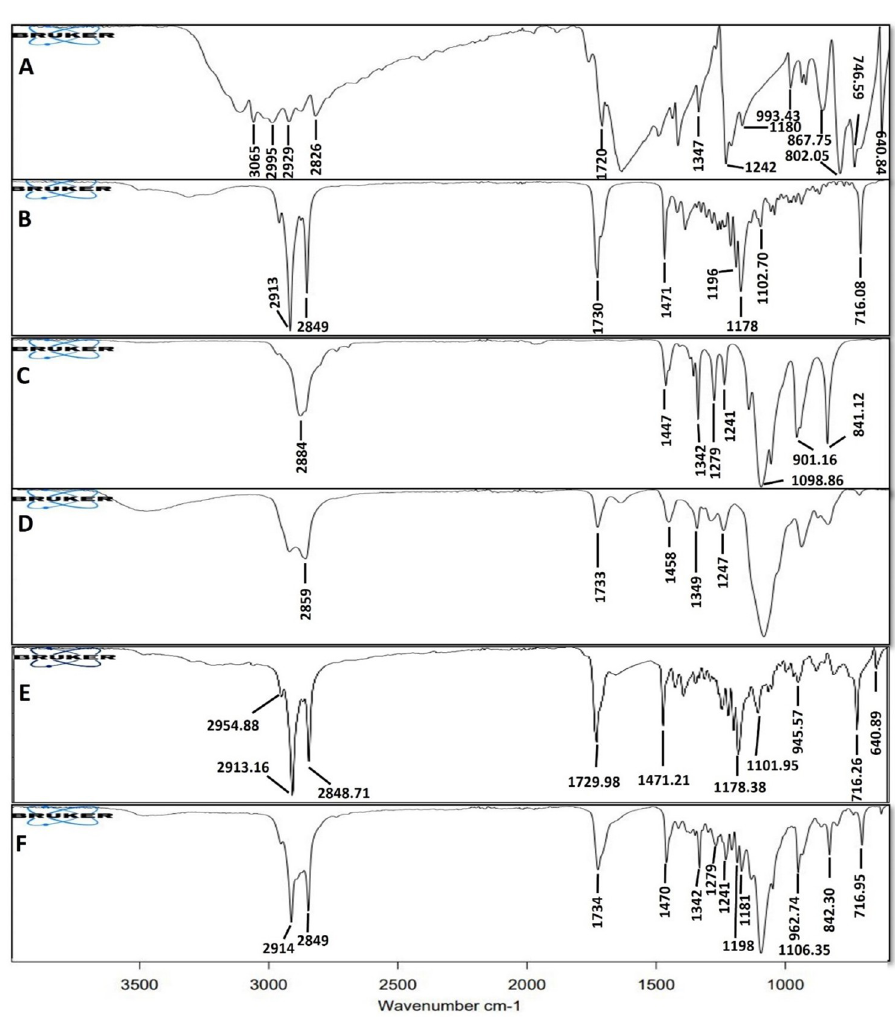
Fig 2. FTIR analysis of 5-FU (A), Precirol 1 ATO 5 (B), Poloxamer 188 (C), Tween 80 (D), Physical mixture (E), and optimized formulation (F).